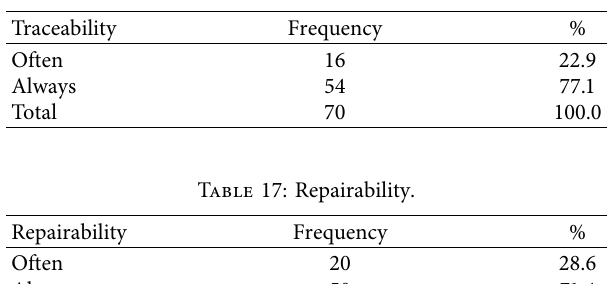
Table 16: Traceability.